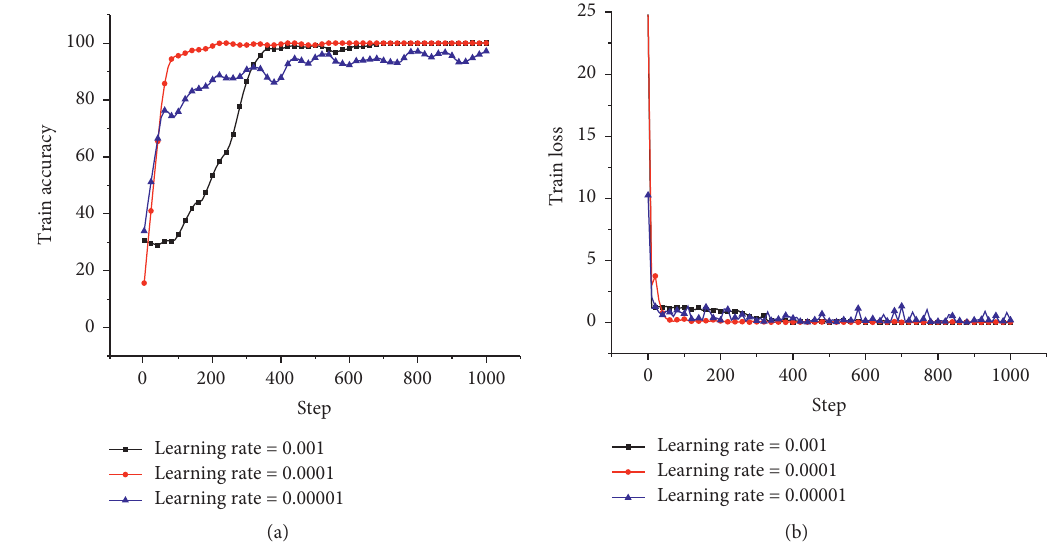
Figure 10: Comparison of training processes with different initial learning rates: (a) training accuracy; (b) training loss. Table 2: Comparison of test results with different initial learning rates.